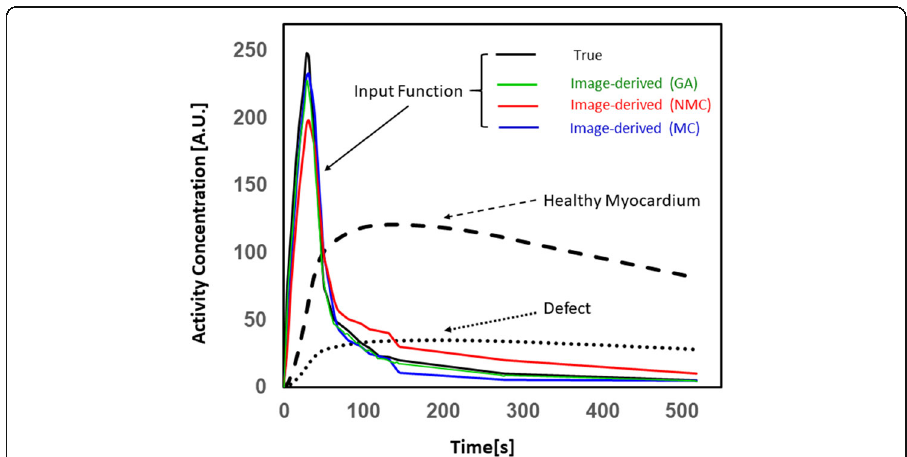
Fig. 2 The input function and TACs for the healthy myocardium and defect. The true function is